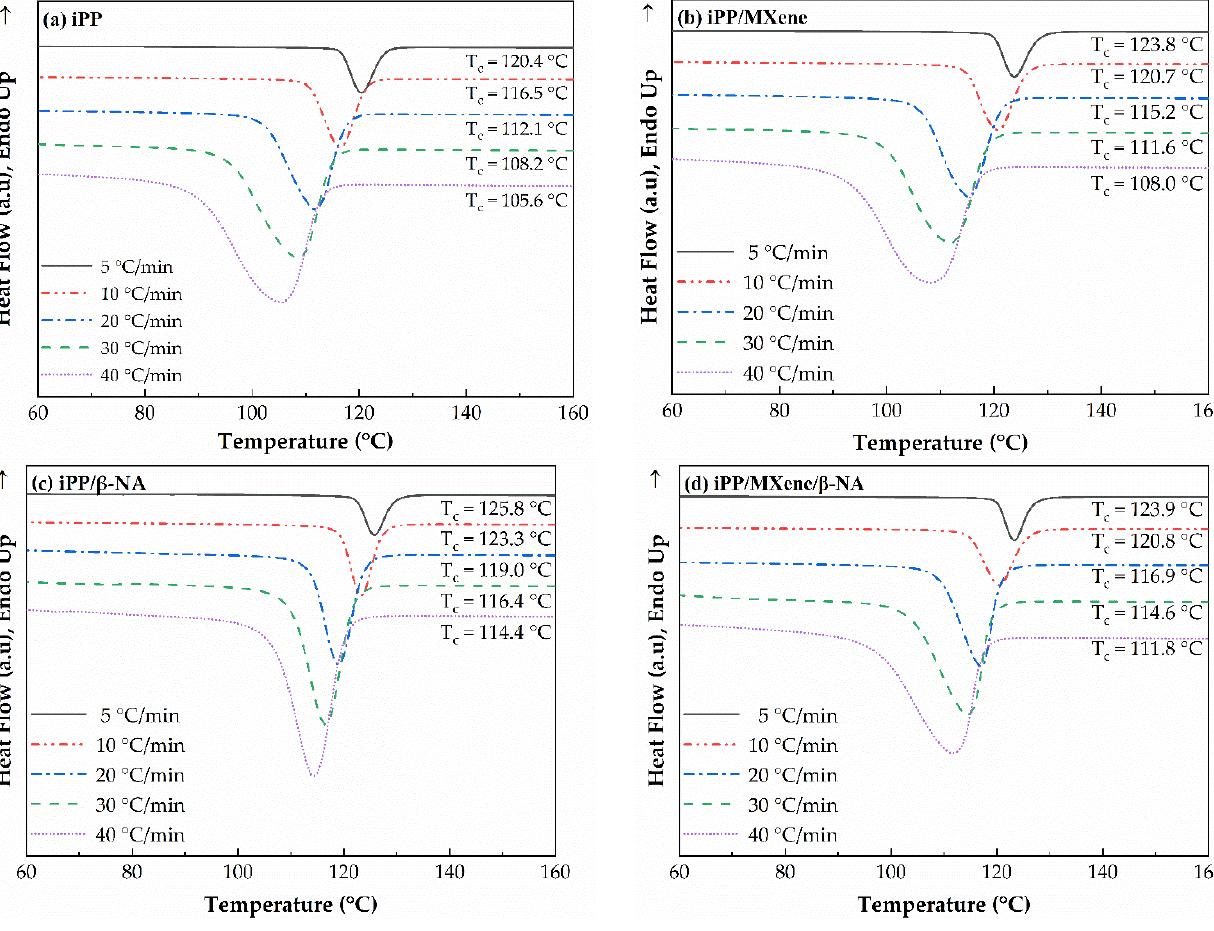
Figure 4. DSC cooling curves of ( a ) neat iPP, ( b ) iPP/MXene, ( c ) iPP/ β -NA, and, ( d ) iPP/MXene/ β -NA at cooling rates 5, 10, 20, 30, and 40 °C/min.